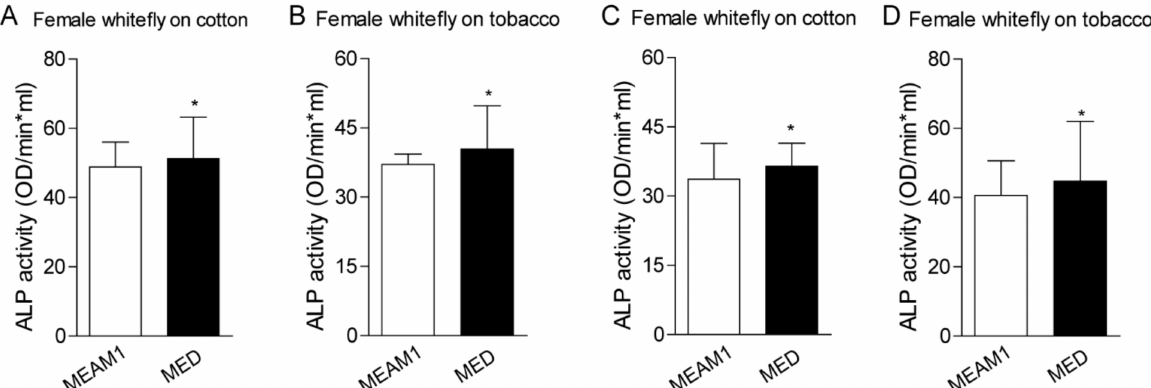
Figure 4. ALP activity analysis in whiteflies fed on cotton and tobacco. Each dot represents one female/male whitefly ALP activity. ( A , B )—female whitefly on the cotton and tobacco from MEAM1 and MED whiteflies; ( C , D )—male whitefly on the cotton and tobacco from MEAM1 and MED whiteflies. * indicates p < 0.05.